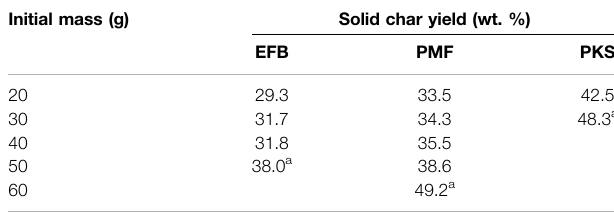
TABLE 4 | Solid char yield of oil palm biomass at different initial mass. Initial mass